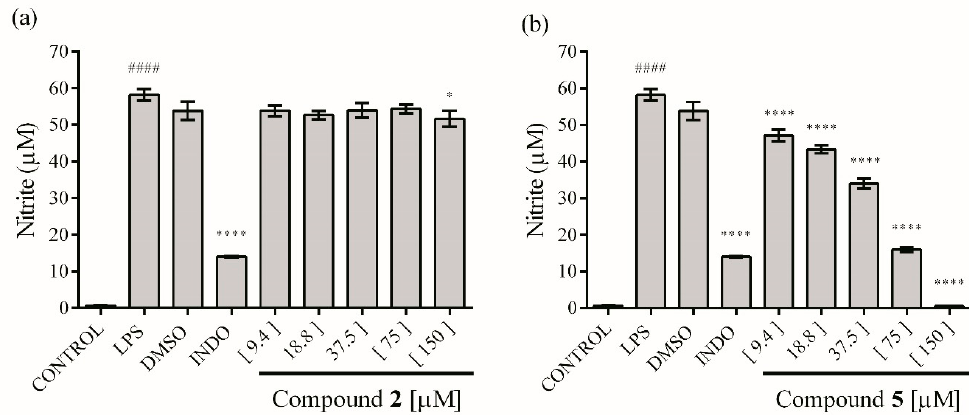
Figure 4. Effect of compounds 2 ( a ) and 5 ( b ) on NO production in lipopolysaccharide (LPS)-stimulated RAW 264.7 macrophages. The values are expressed as the mean ± SD of three independent experiments ( n = 3). Significance was determined using ANOVA followed by Dunnett’s multiple comparisons test ( #### p < 0.0001 LPS compared with control group; * p < 0.05 and **** p < 0.0001 DMSO, INDO (indomethacin) and compounds compared with LPS group).